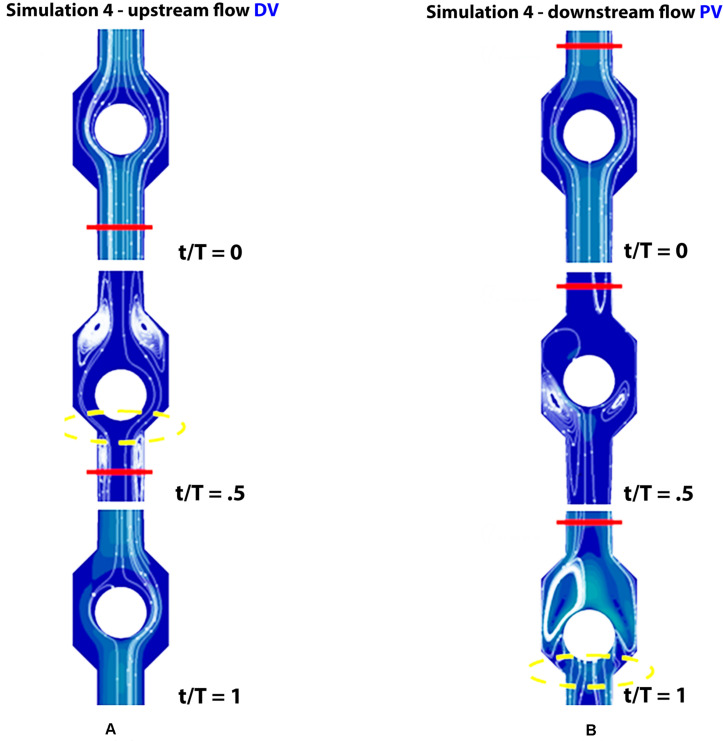
Valve positions in different phases of the walking cycle, lasting 1 s, in subjects with severe dysfunction (simulation 4). Upstream of the distal valve (A) and downstream of the proximal valve (B), incompetent valves space are marked by yellow dashed lines.